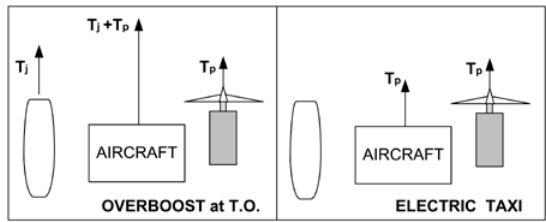
Fig. 1. Hybrid propulsion scheme for jet propelled aircraft